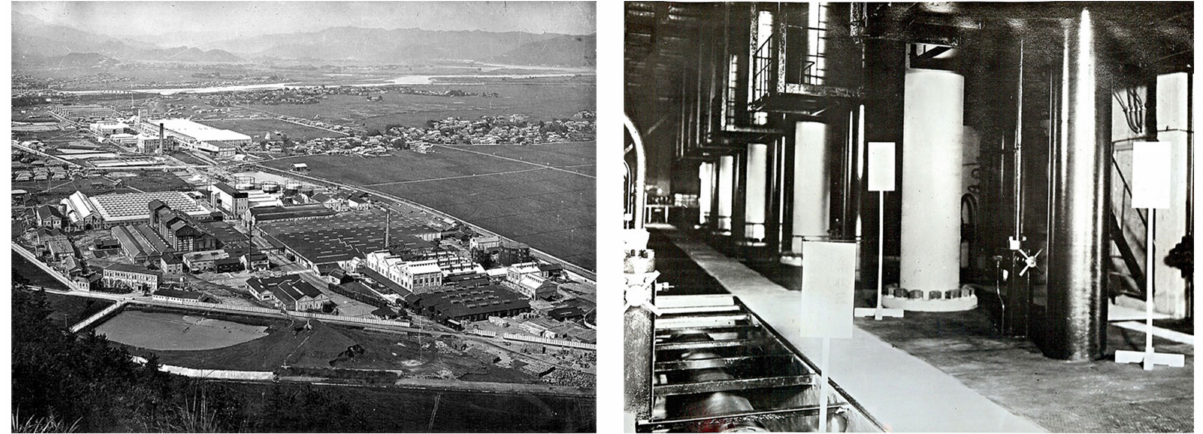
Figure 5. Left: Nobeoka ammonia factory in Japan, around 1924. Courtesy Casale S.A. Right: Ammo- nia converters at Minamata, Japan. Courtesy Casale